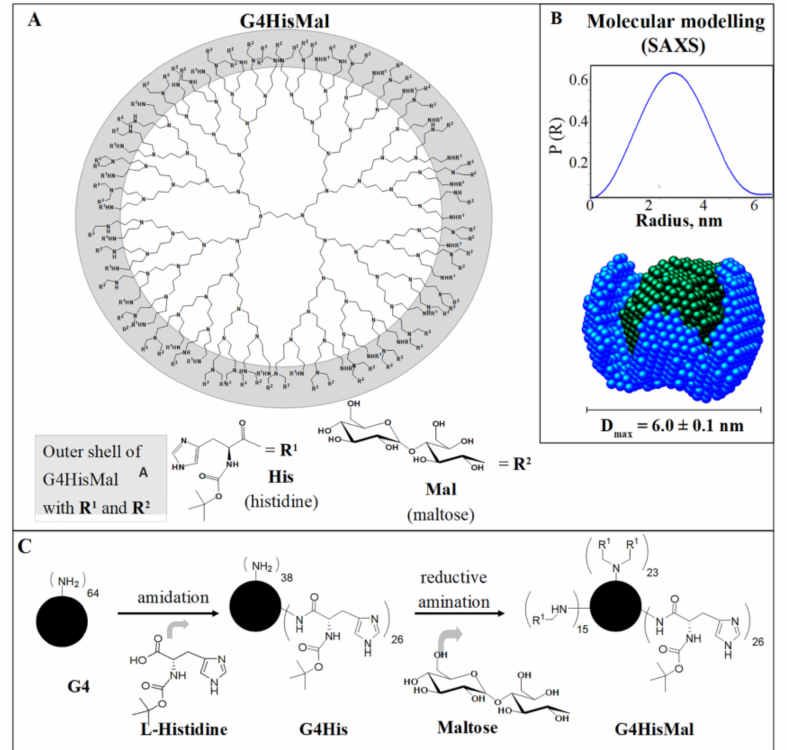
Figure 10. Structure and synthesis of G4HisMal. ( A ) Simplified structure of G4HisMal. Layers 1–4 indicate dendrimer’s branching points and generation of the dendrimer. Layer 4 shows N terminal groups with maltose as R1 and histidine as R2 substituents. ( B ) Distance distribution functions P(R) of G4HisMal in PBS calculated SAXS pattern of G4HisMal in PBS at 37 ◦ C using GNOM.40 Insertion: De novo three-dimensional reconstruction of the scattering entity of G4HisMal using DAMMIF after 10 independent reconstructions. A line indicates the maximum dimension (Dmax). UCSF Chimera41 was used for visualization. ( C ) Reaction pathway for synthesizing glycodendrimer G4HisMal. Reprinted with permission from ref. [178]. Copyright 2019,